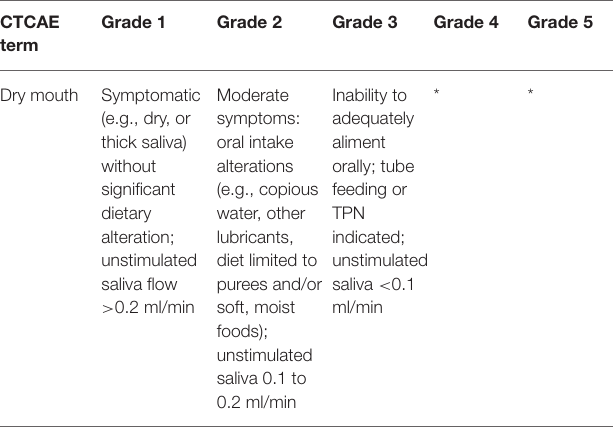
TABLE 1 | Common Terminology Criteria for Adverse Events (CTCAE) for dry